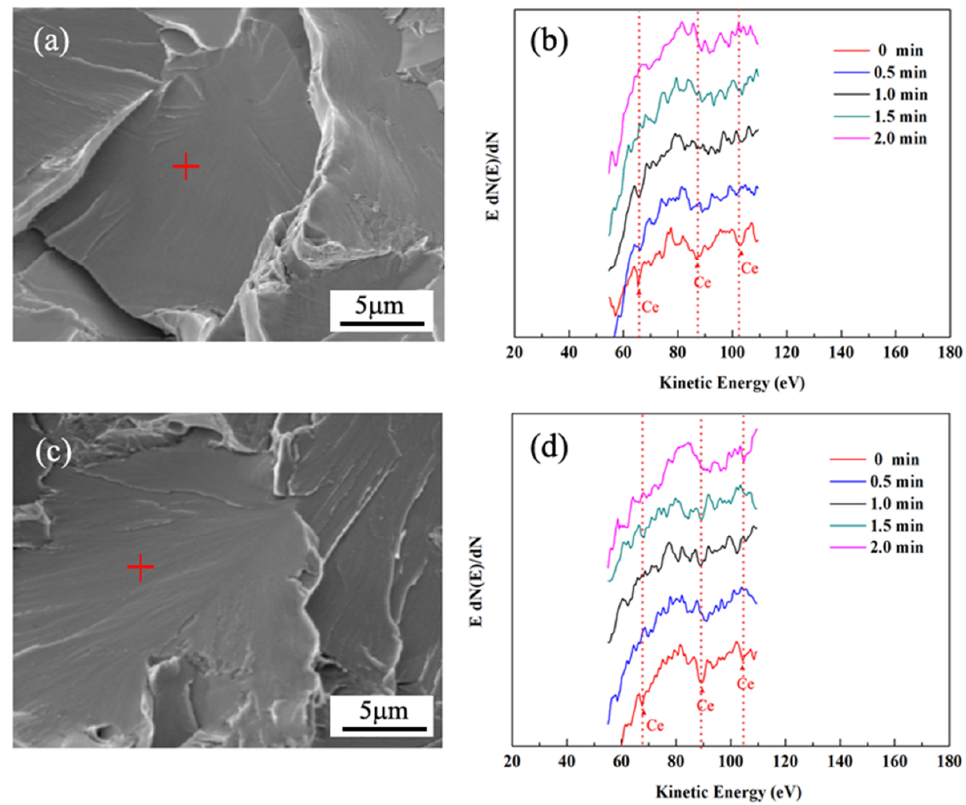
Figure 7. Intergranular impact fracture morphology (red plus sign marks the location where AES test is conducted) and AES spectrum of Ce in Q235BM ( a ) and ( b ) and in Q355BM ( c ) and ( d ).